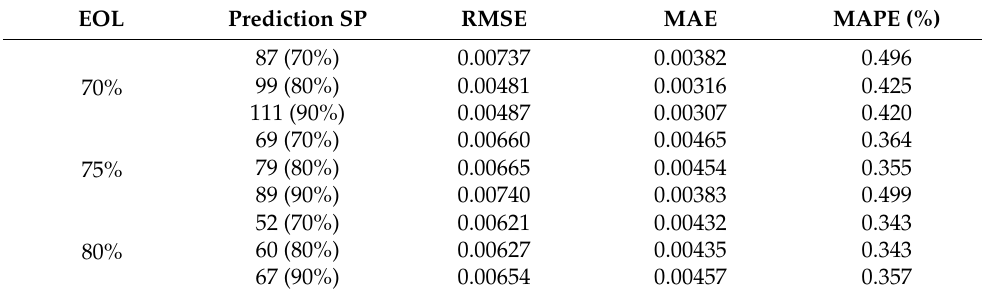
Table 6. Prediction results of SOH based on the M4 model for the B0005 battery with different EOLs.